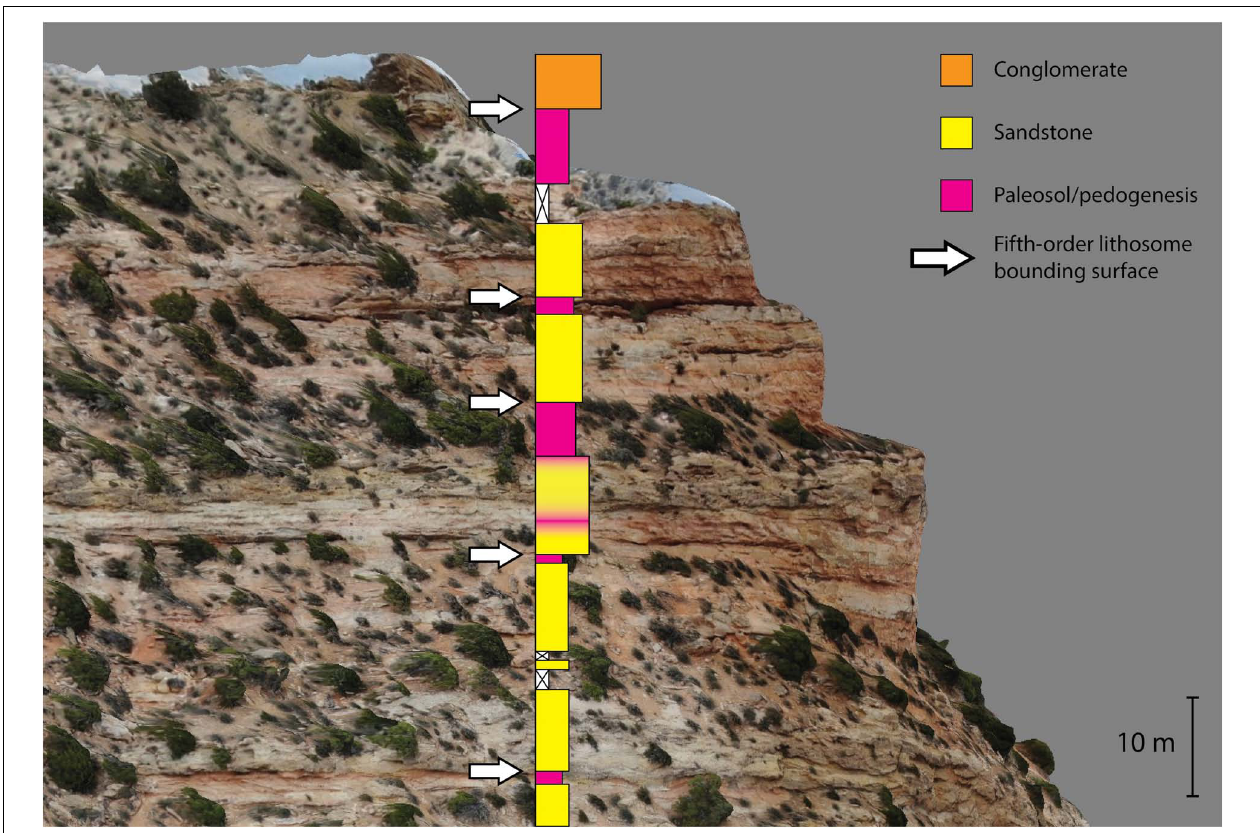
FIGURE 8 | Small portion of the digital outcrop model from the western end of Richards Mountain with a simplified portion of the Richards Mountain Measured Section 2 ( Figure 7B ) overlain for facies correlation. Fifth-order bounding surfaces are marked by white arrows. These bounding surfaces can generally be recognized by their lateral continuity and the frequent presence of a recessive paleosol cap on the underlying lithosome. The boundary between lithosomes is placed at the top of this paleosol cap, where channel-filling sandstones or conglomerates of the overlying lithosome scour into the paleosols. Note that each fifth-order bounding surface corresponds with the top of a paleosol on the sedimentary